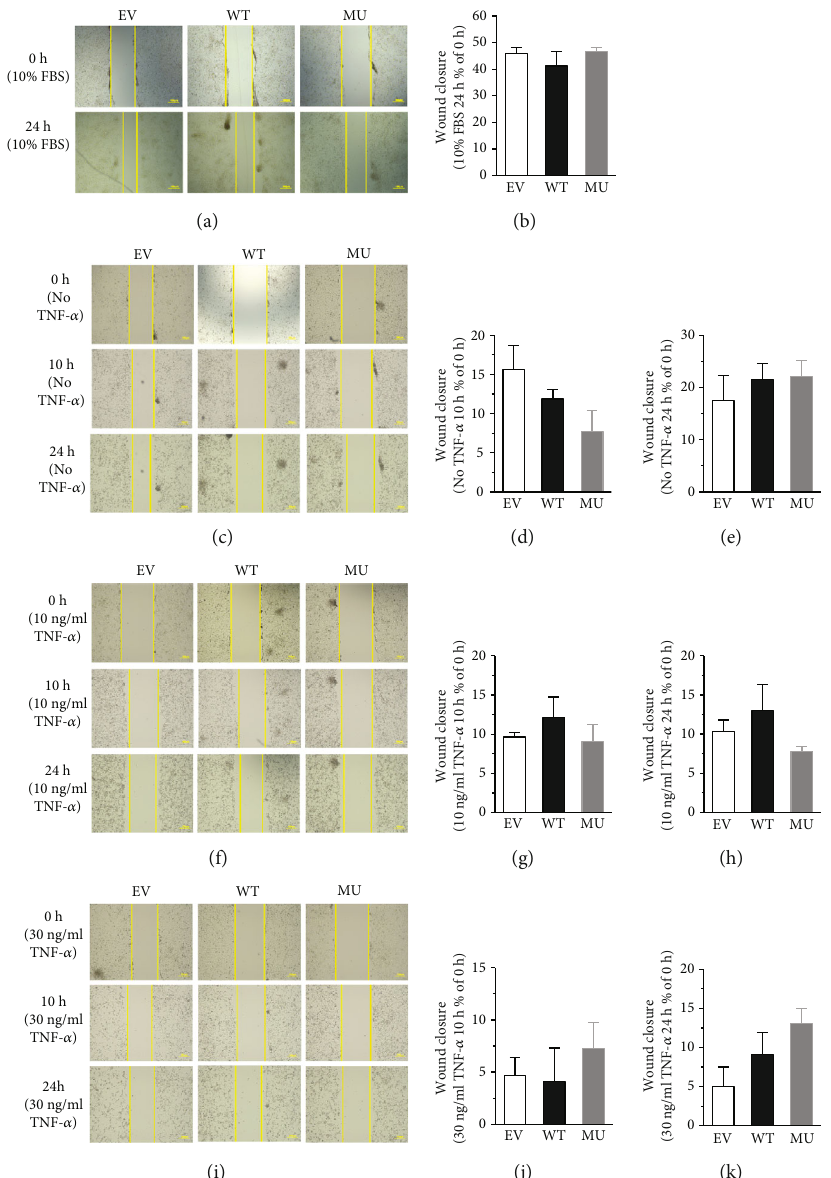
Figure 3: Deletion of GATA4 C-terminus did not alter RCSMC migration. Wound healing assay was adopted to observe the migratory rate of RCSMC. The quantitative analysis of wound healing assay was presented by the wound closure rate relative to the initial distance. Magni fi cation: 4 × 40 . (a, b) Representative images of migrated cells incubated with 10% FBS taken at 0 and 24 h after injury. One-way ANOVA, P > 0 : 05 versus WT, n = 3 . (c – k) Representative images of migrated cells stimulated by TNF- α (10 or 30 ng/ml) taken at 0, 10, and 24 h after injury. One-way ANOVA, P > 0 : 05 versus WT, n = 4